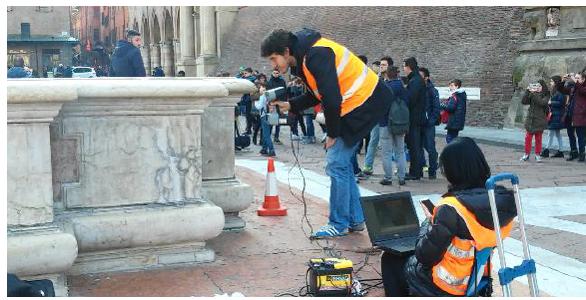
Figure 10. Surveying activities for the basement 3D modelling. The two adopted instruments (both Artec scanners) have an intrinsic precision of 0.1 mm and allow the direct generation of a mesh already enriched with radiometric information.